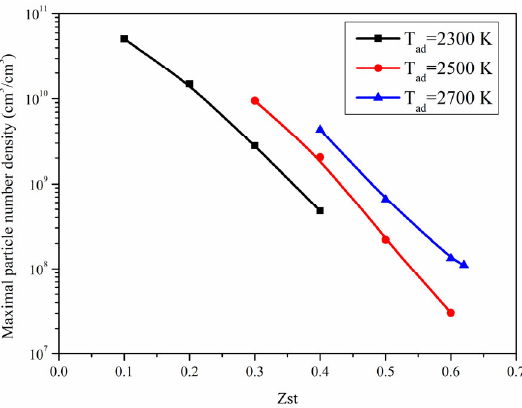
Figure 6. The maximal particle number density in the calculated 3 × 4 conditions.